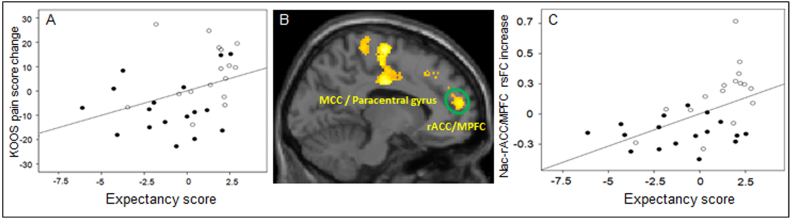
A. Partial plot showing the positive association between the expectancy scores after the expectancy manipulation in session 2 (x axis) and KOOS pain increases (clinical improvement) after six acupuncture treatments (y axis), including age and gender as covariates (p = 0.04) across the two acupuncture groups (solid dot indicates standard acupuncture group, hollow dot indicates boosted acupuncture group). B. Representative brain regions showed a significant rsFC increase in boosted acupuncture as compared to standard acupuncture (voxel-wise p < 0.005, and cluster-level p < 0.05 FWE corrected). C. The scatter plot represents the partial plot showing the positive association between the expectancy score (x axis) after expectancy manipulation in session 2 and NAc and rACC/MPFC connectivity changes (y axis), including age and gender as covariates (p = 0.002). MCC, middle cingulate cortex; rACC, rostral anterior cingulate cortex; MPFC, medial prefrontal cortex.